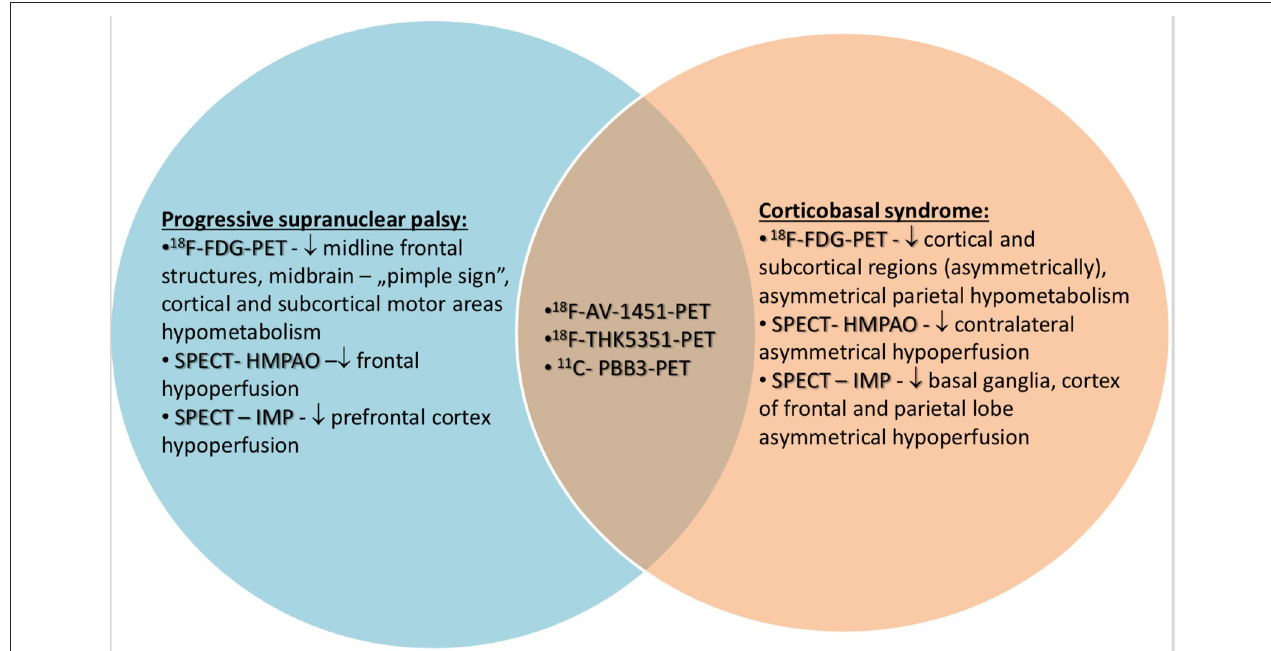
FIGURE 1 | Possibilites and limitations of PET and SPECT in the examination of PSP and CBS.